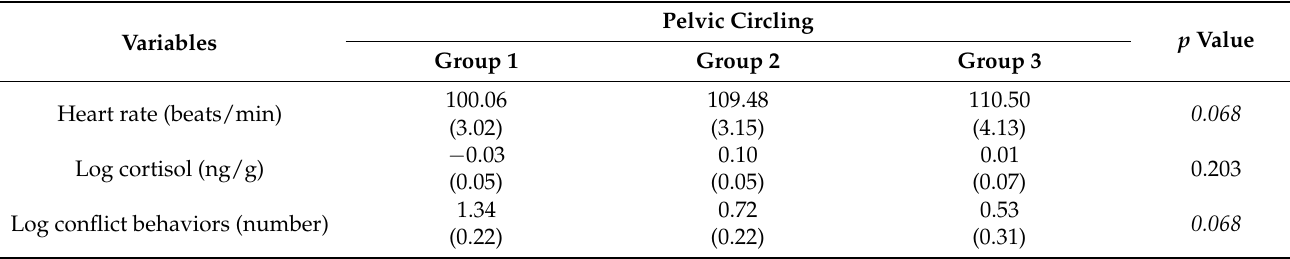
Table 3. Mean values and standard error of the mean for physiological and behavioral variables of the horse according to grade awarded for rider’s pelvic circling ability (Group 1 = poor, Group 2 = medium, Group 3 = good). Cortisol values are average of samples taken at 0 min and 5 min post-exercise.